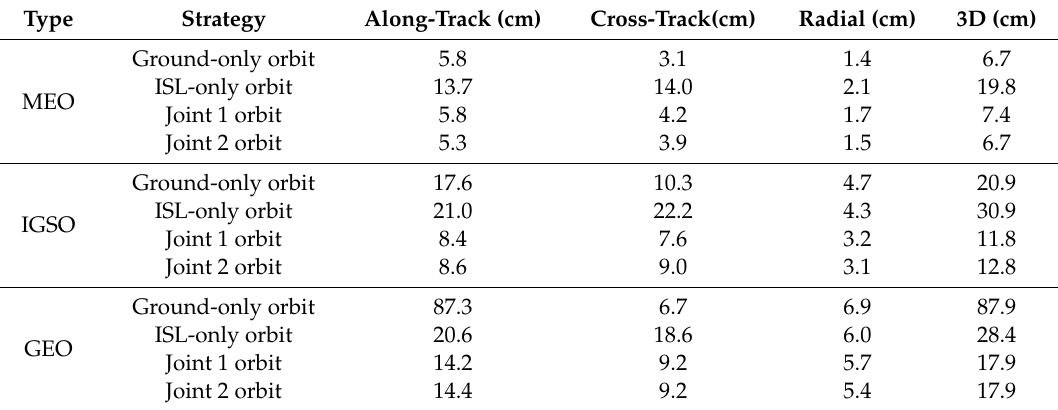
Figure 3. Comparison of two-day arc overlapping di ff erence of ground-only orbit, ISL-only orbit, Joint 1 orbit, and Joint 2 orbit based on MEO / IGSO satellites three-day arcs solution. Table 2. RMS of two-day arc overlapping di ff erence of ground-only orbit, ISL-only orbit, Joint 1 orbit, and Joint 2 orbit based on three-day arcs solutions according to the satellite type.